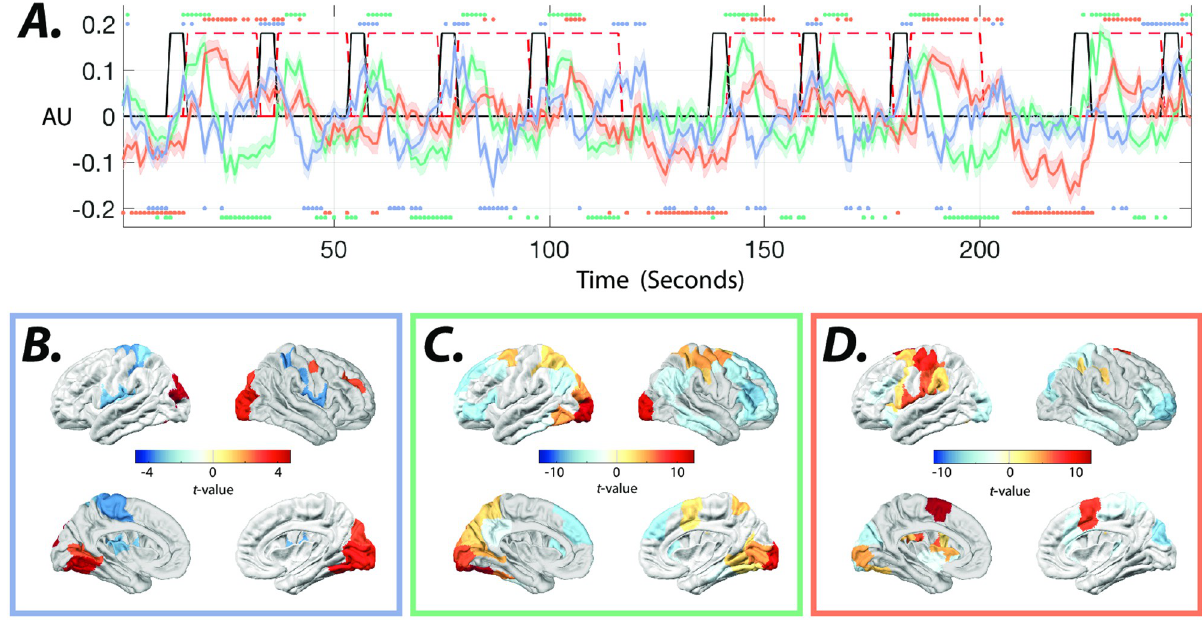
Fig 7. Temporal and spatial profiles of estimated external inputs associated with visual cues. (A) Color-coded lines show the mean and standard error (shaded area) of estimated inputs with the highest subject-level loadings for PCs 1 (green), 3 (orange), and 5 (blue). Time points with significant ( t − test, p < 0.05, FDR corrected for multiple comparisons across time points) divergence from zero are marked with color-coded dots. The black and dashed red lines show the visual cue and motor task blocks, respectively. Color-coded panels (B-D) show the t − test values of brain regions with significant ( t − test, p < 0.05, FDR corrected for multiple comparisons across ROIs) loadings on input matrix B rows corresponding to the aforementioned PCs.